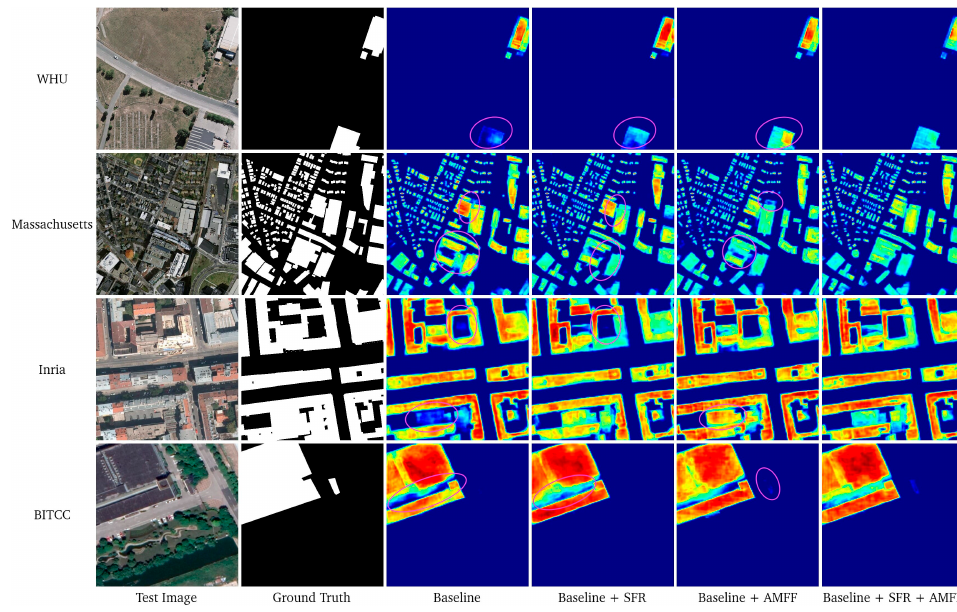
Figure 16. Visualization of feature maps by the selected models with four datasets (ablation